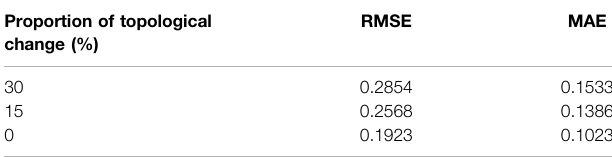
TABLE 3 | Prediction performance for different input features.